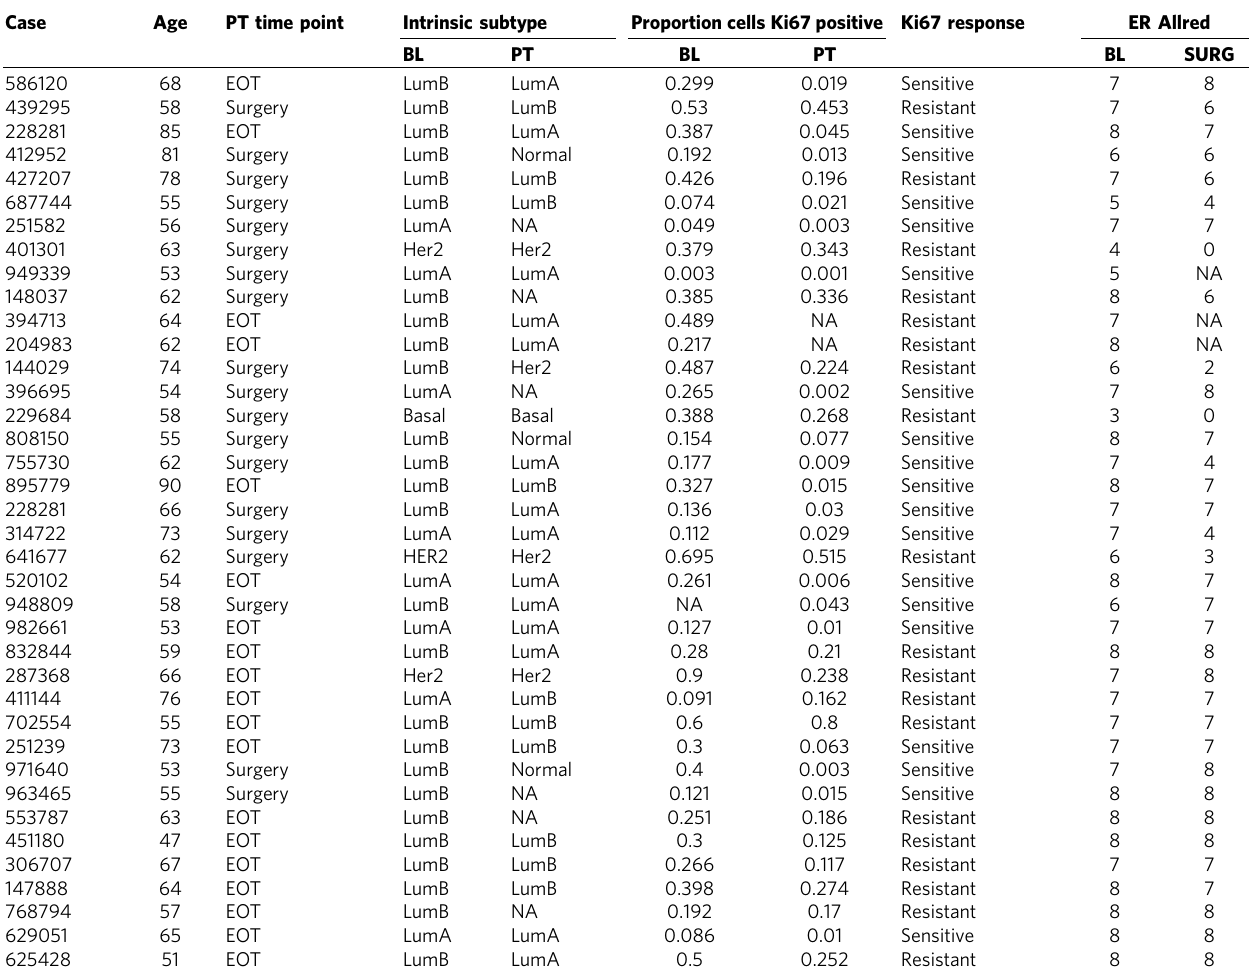
Table 2 | Thirty-eight additional cases sequenced with an 83-gene panel and a description of key clinical and biomarker